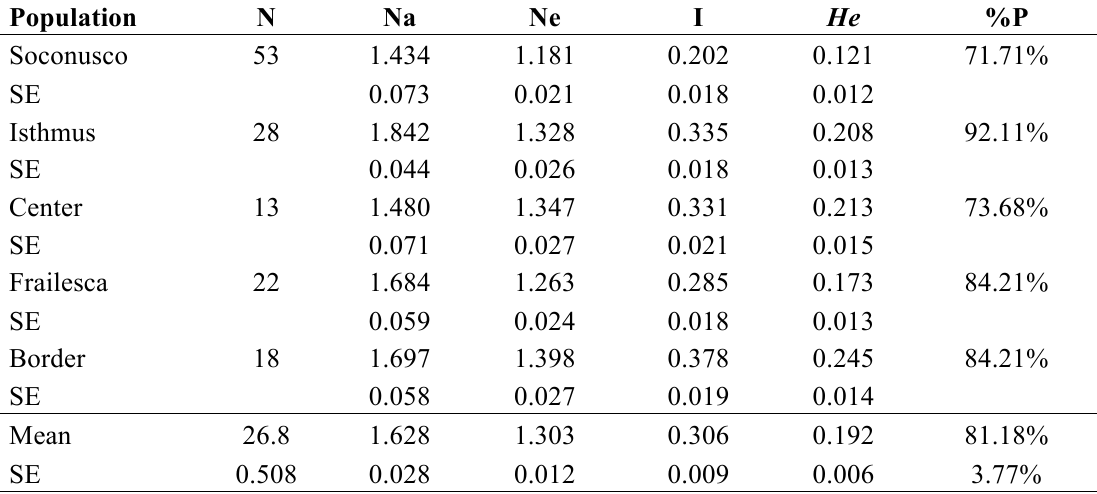
Table 2. Genetic diversity parameters of 134 accessions of J. curcas of Chiapas, Mexico, grouped in five